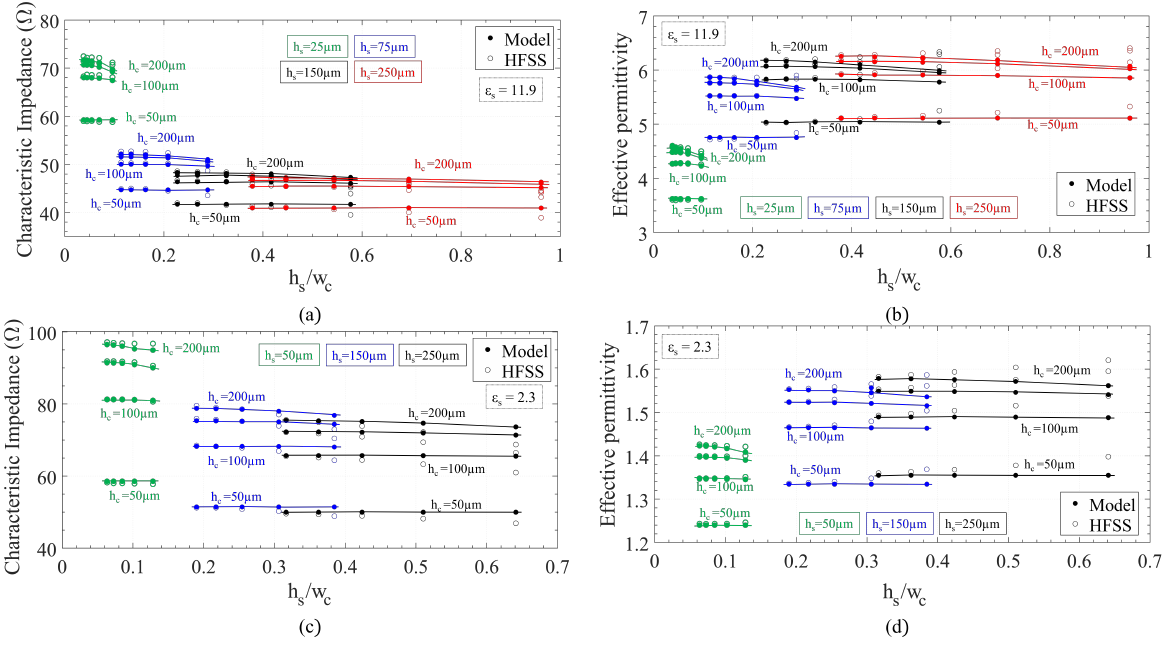
Figure 5. Comparison between closed-form expressions and finite element simulations for the IGCPW line. ( a ) Z 0 for high-permittivity substrate. ( b ) (cid:101) ef f for high-permittivity substrate. ( c ) Z 0 for low-permittivity substrate. ( d ) (cid:101) ef f for low-permittivity